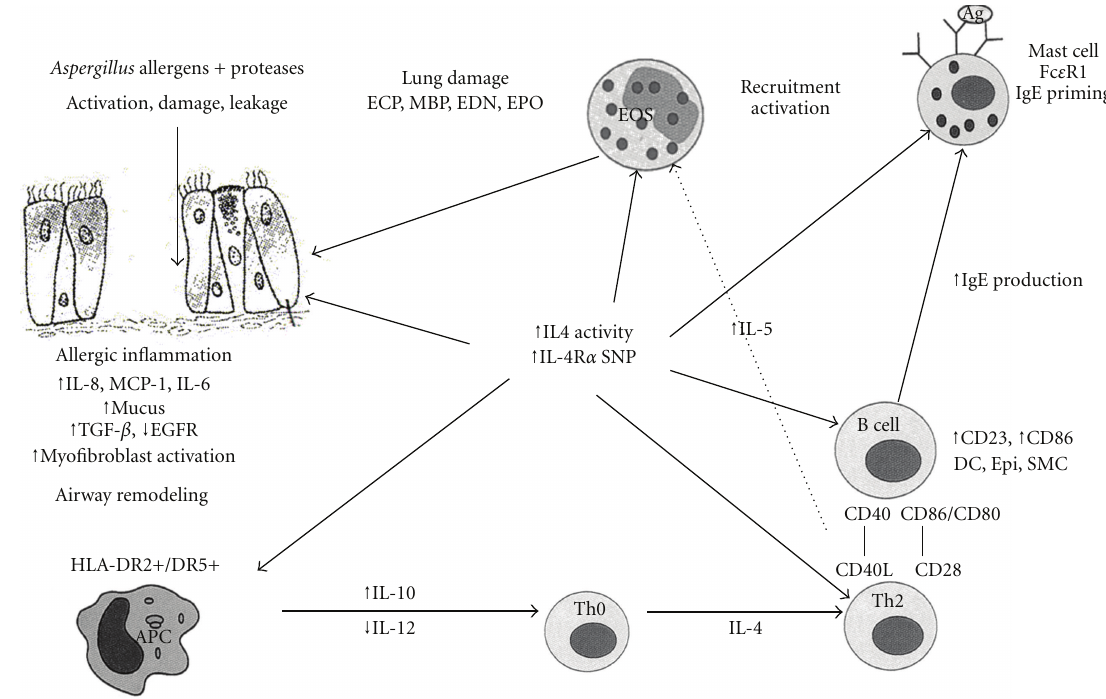
Figure 1: Proposed immunopathogenesis of ABPA. In the pathogenesis of ABPA, A. fumigatus proteases have a direct e ff ect on bronchial epithelia causing epithelial cell damage with subsequent stimulation of cytokines and chemokines. Aspergillus proteins are processed via HLA-DR2/DR5 bearing dendritic cells that skew the Th0 response to a Th2 response. Th2 cytokines stimulate IgE synthesis and eosinophil activation. This leads to an eosinophilic inflammatory in the bronchial airways. Abbreviations: Af: Aspergillus fumigates, Asp fx: Aspergillus fumigatus proteins, APC: antigen presenting cell, MBP: major basic protein, ECP: eosinophil cationic protein, EDN: eosinophil derived neurotoxin, VLA: very late activation antigen, VCAM: vascular cell adhesion molecule, CxCR and CCR: chemokines receptors,